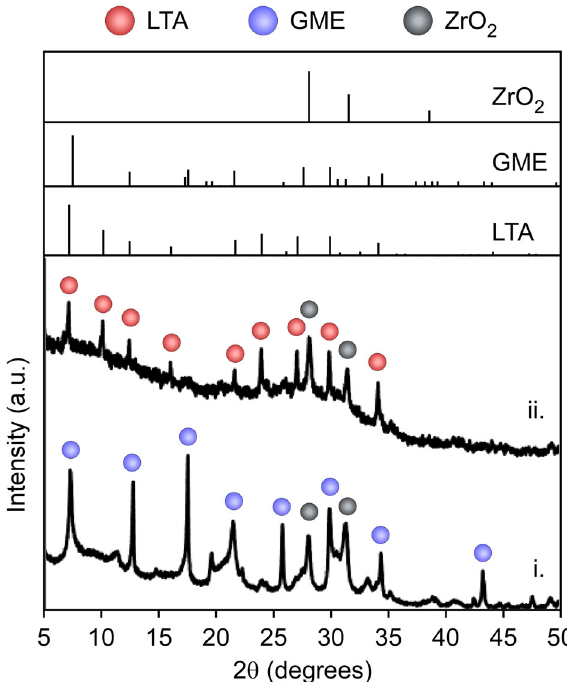
Fig. 4 Deconvoluting Sn and Ca. PXRD patterns illustrating the effect of tin on samples synthesized with a molar composition similar to that of eLAW-21 (Supplementary Table 2). (i) eLAW-21 synthesis repeated in the absence of Ca and Sn. (ii) eLAW-21 synthesis repeated in the absence of Ca and in the presence of Sn. Solid products were extracted from syntheses after 7 days at 100 °C. Reference patterns of ZrO 2 , GME, and LTA are provided. The PXRD pattern of solid generated from the original eLAW-21 synthesis is displayed in Supplementary Fig. 4 for reference.